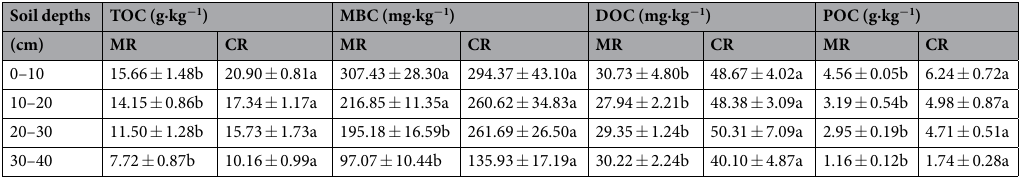
Table 3. Soil organic carbon and its active components under different treatments. MR, rice monoculture model; CR, Integrated rice–crayfish model. TOC, total organic carbon; MBC, microbial biomass carbon; DOC, dissolved organic carbon; POC, particulate organic carbon. Means with different letters for the same property in the same soil layer indicate significant differences at p < 0.05. Values are means ± standard errors.